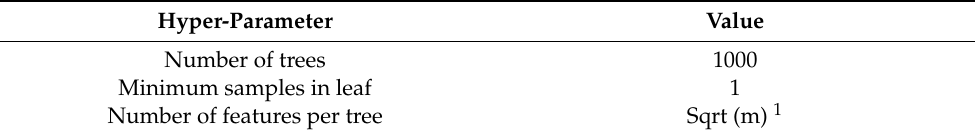
Table 3. Optimal hyper-parameters of the model.